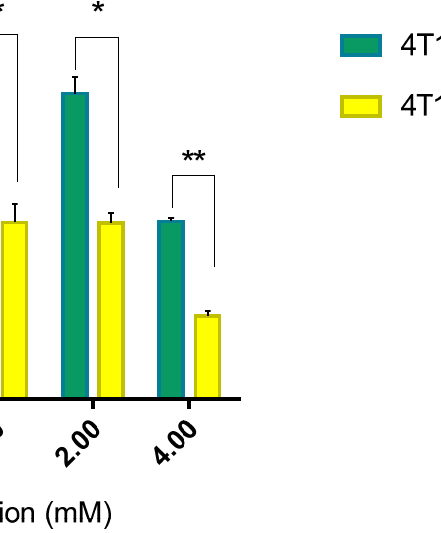
Figure 3. Cytotoxicity assay of various FAS concentrations in the growth medium for 4T1 and 4T1-Qt cells. The data are shown as the mean + S.D. of three independent experiments. p values were calculated using a one-tailed t -test, assuming unequal variances (** indicate p -value < 0.001, * indicate p -value <